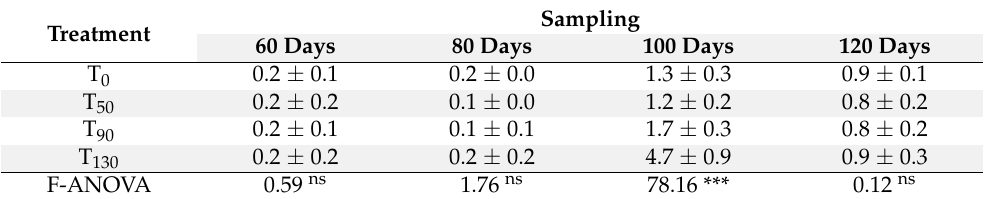
Table 11. Cadmium content ( µ g/L) in leachates. Entries represent means ± standard errors from n = 3